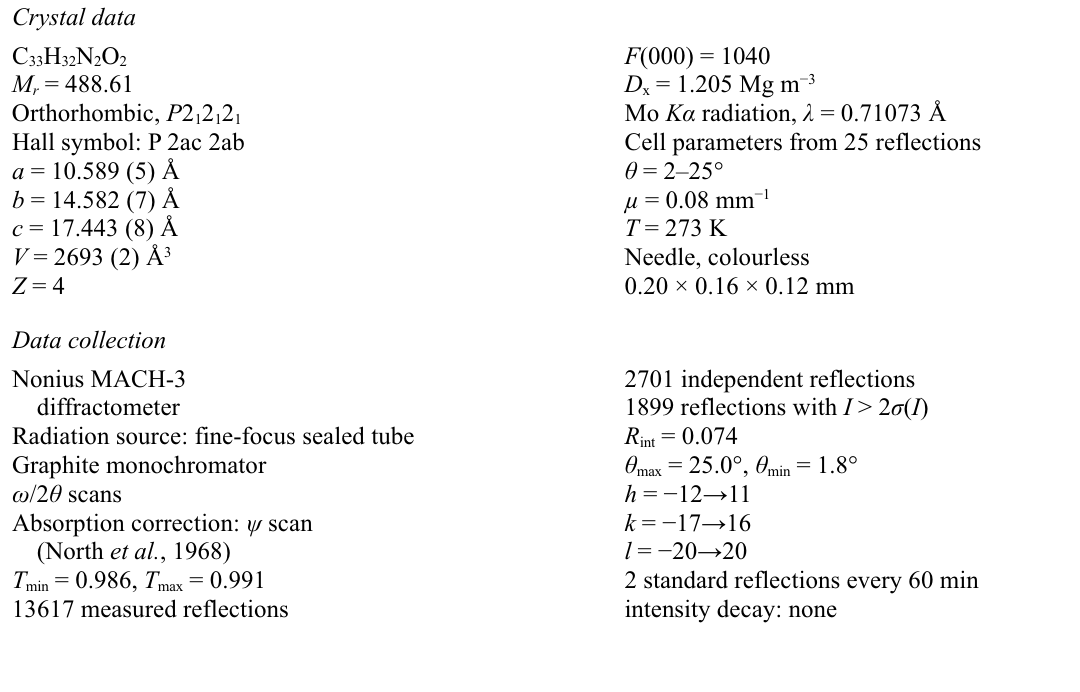
sup-2 Acta Cryst. (2008). E 64 , o343